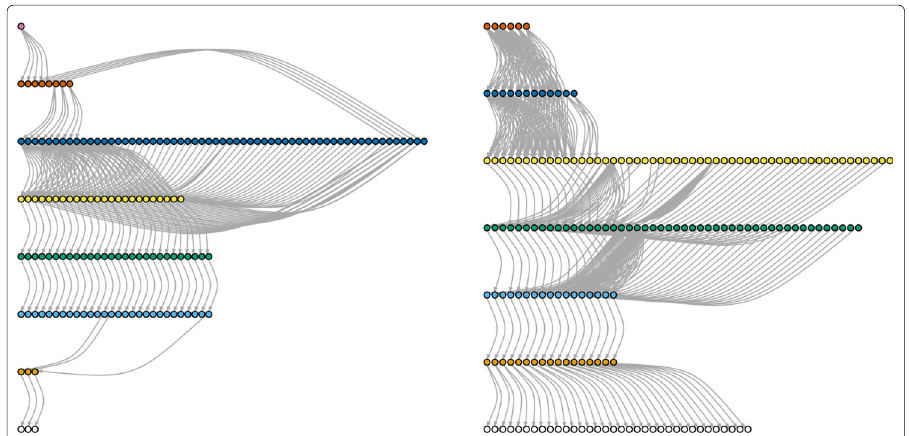
Fig. 2 A visual representation of the tiered structure of the real-world supply networks obtained from the dataset. The images correspond to supply chains of Computer Peripheral Equipment (left) and Perfumes, Cosmetics, and Other Toilet Preparations